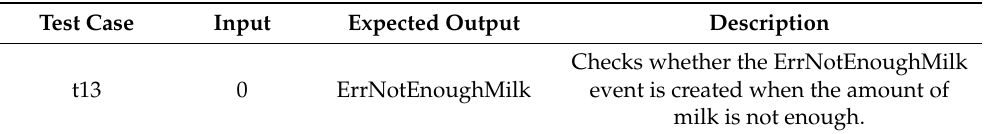
Figure 5. The feature model for SPL V2 . Table 10. New test cases for SPL V2 .